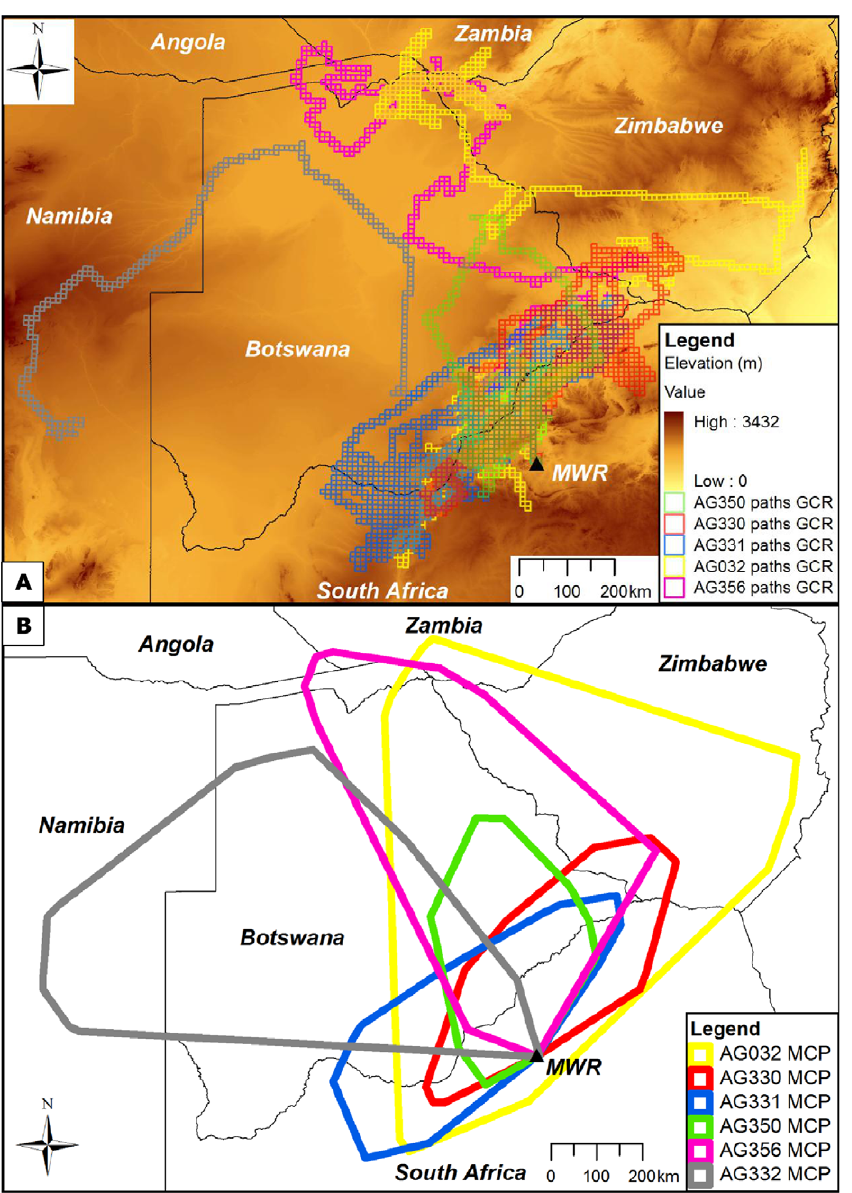
Figure 1. Foraging ranges represented by (A) path GCRs and (B) MCPs for six immature African white-backed vultures. Path GCRs (A) represent 10 6 10 km grid cells intersected by a continuous line between all consecutive GPS locations recorded during the total tracking period of each vulture. MCPs (B) were created by connecting the outermost GPS locations recorded for each vulture. Mankwe Wildlife Reserve capture site is indicated by a black triangle and ‘‘MWR’’.